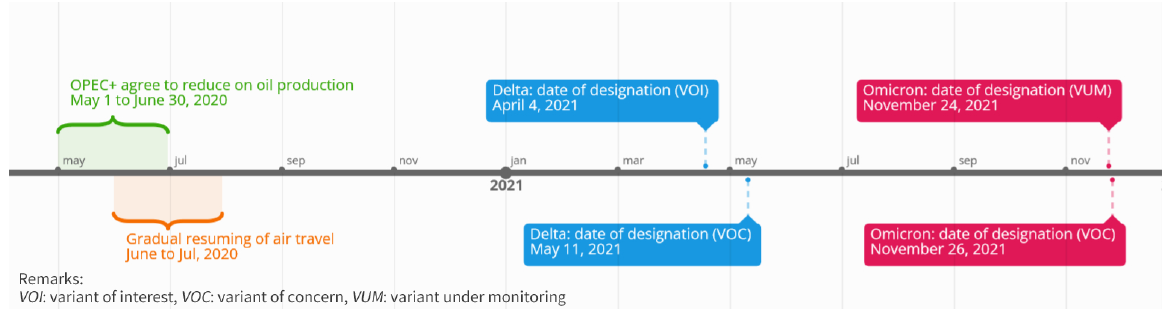
Figure 4. Timeline of some key events related to COVID-19 or the oil market.